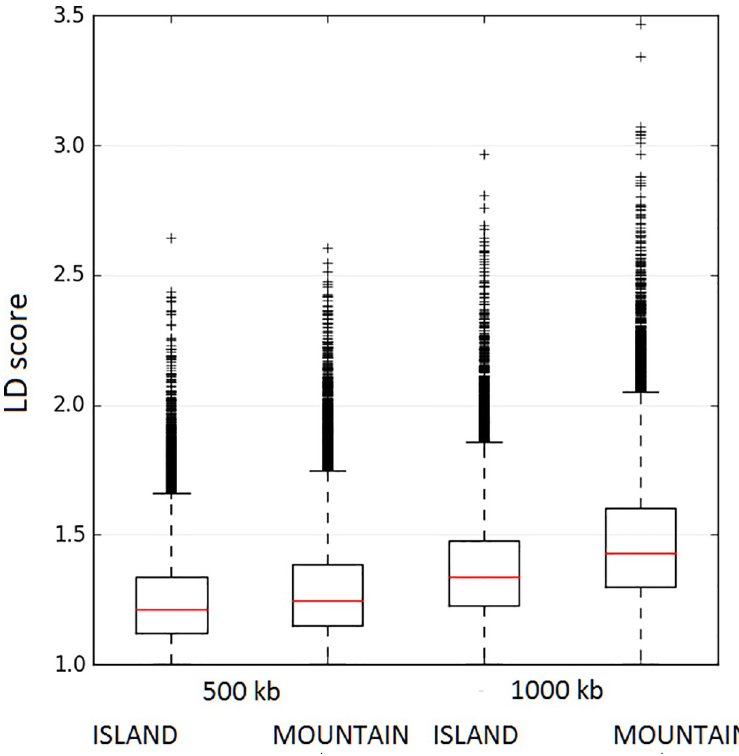
Fig 3. Box plots of LD scores for 500 kb and 1000 kb windows for mainland- island sheep